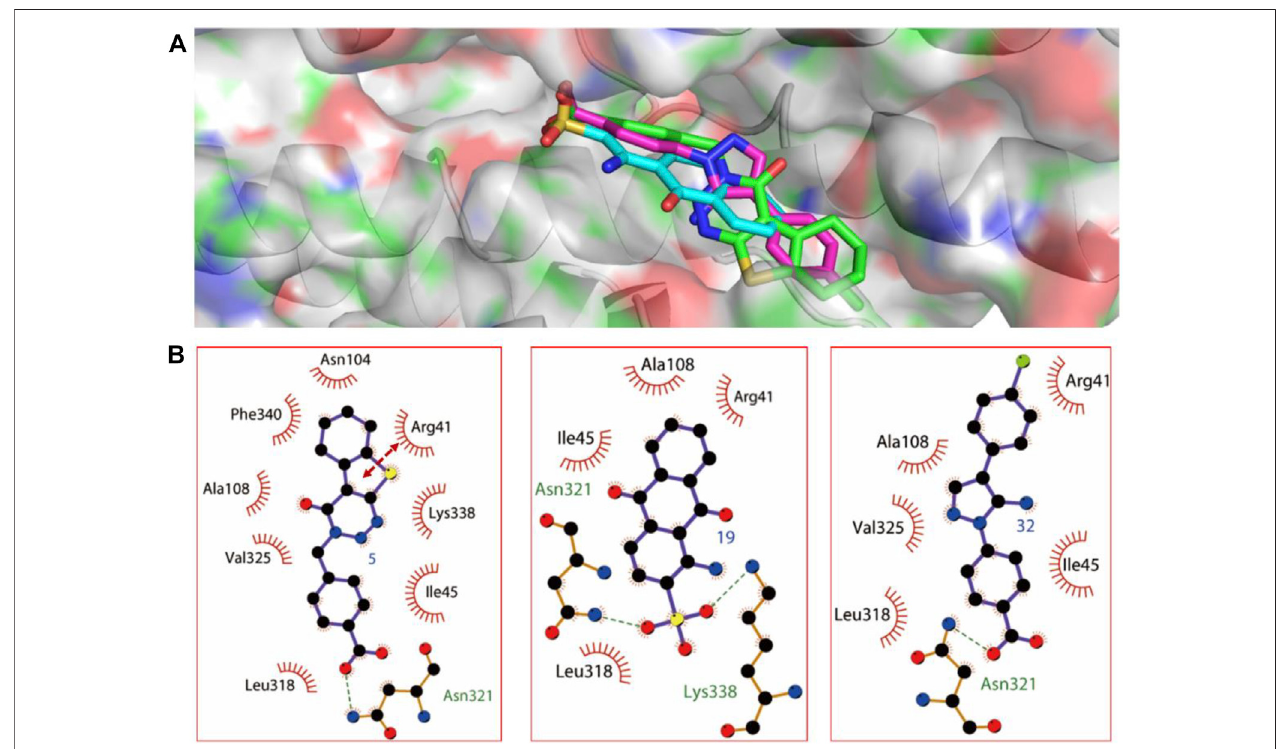
FIGURE 4 | The predicted binding modes of compounds 5, 19, and 32. (A) The three dimensional binding mode of compounds 5, 19, and 32. (B) The relative schematic diagram showed the hydrophobic interactions (shown as starbursts), H-bond interactions (denoted by dotted green lines), and π - π interactions (displayed as double-head arrow) between compounds 5, 19, and 32 with T3SS tip protein SipD.